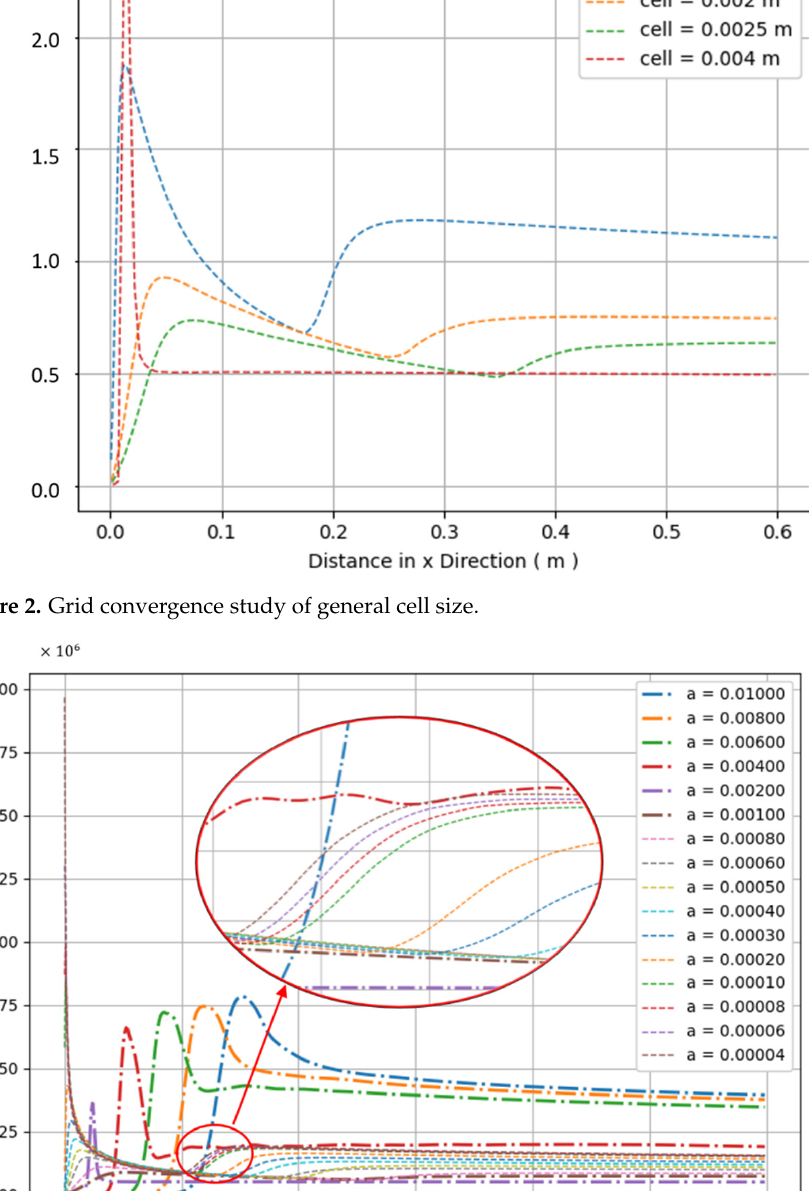
Figure 2. Grid convergence study of general cell size.